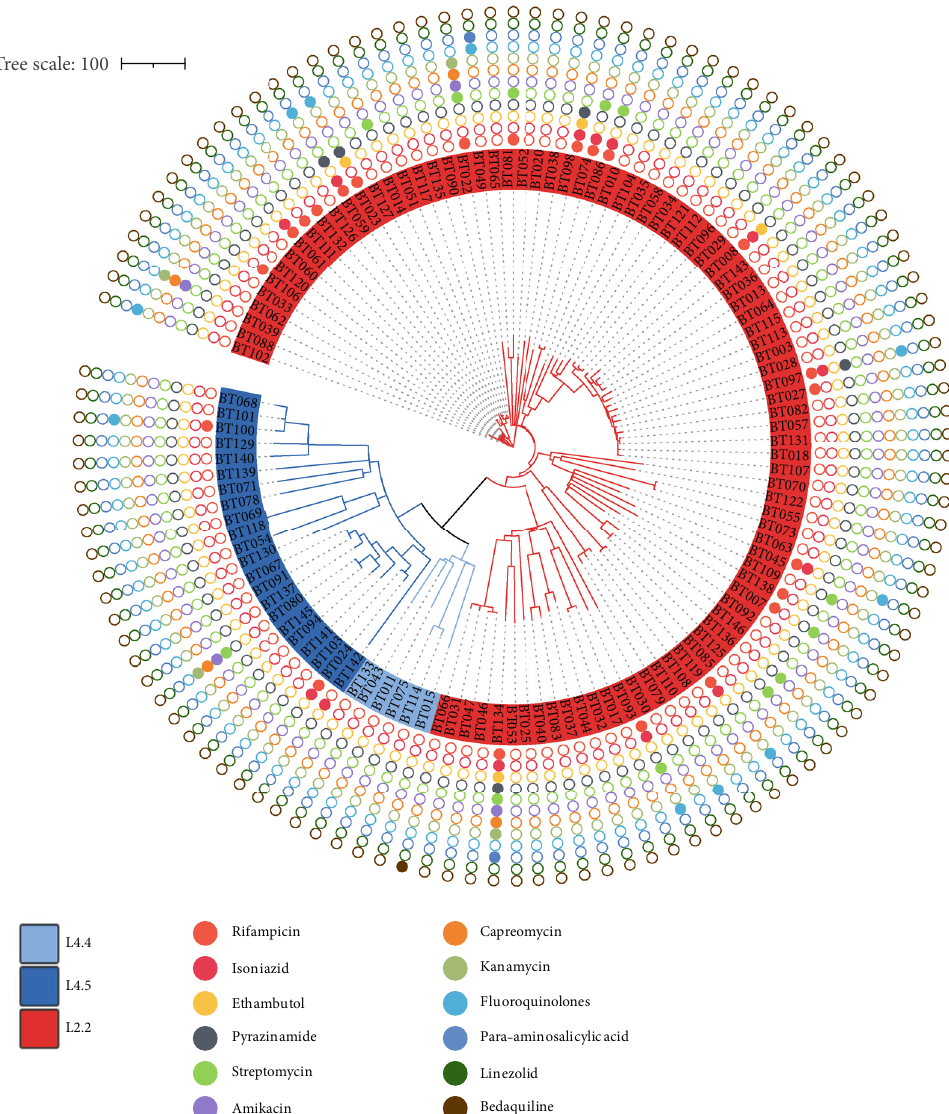
Figure 1: Phylogenetic tree for 116 M. tuberculosis isolates from the Yi ethnic group. From inside to outside, the solid-coloured circles represent drug resistance mutations for rifampicin, isoniazid, ethambutol, pyrazinamide, streptomycin, amikacin, capreomycin, kanamycin, fl uoroquinolones, para-aminosalicylic acid, linezolid, and were embB _M306V (37.50%, 3/8). One (12.50%, 1/8) of the EMB-resistant strains has combined mutations at two loci. The resistance gene mutations to other drugs are shown in Table 2. 3.4. Characteristics of Drug Susceptibility. The proportions of RR/MDR-TB and pre-XDR-TB in re-treatment patients were higher than in new patients ( χ 2 = 12 : 155 , P = 0 : 003 ; χ 2 = 22 : 495 , P = 0 : 001 , respectively). The pre-XDR-TB pro- portion was higher among female patients ( χ 2 = 5 : 456 , P = 0 : 032 ). The pre-XDR-TB rate was higher among referred patients than among patients from other sources ( χ 2 = 15 : 134 , P = 0 : 002 ). RR/MDR-TB and pre-XDR-TB did not di ff er appreciably among groups with di ff ering HIV infection status nor lineage populations (Table 3).